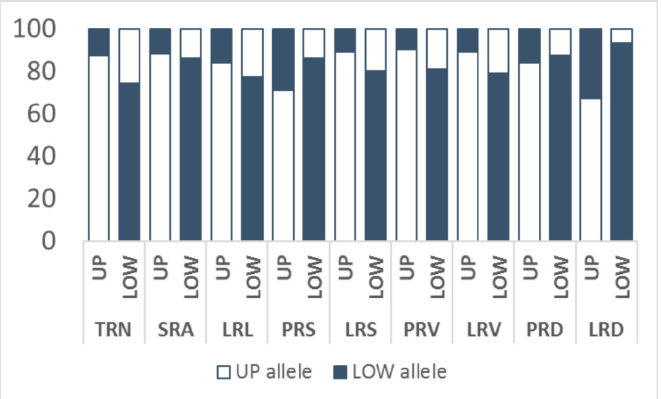
Figure 5. Marker allele frequency means from landraces within the upper and lower 10th percentile for the analyzed traits. All significant markers shown in Table 4 are included. TRN, total root number. SRA, seminal root angle. PRL, primary root length. LRL, total lateral root length. PRS, primary root surface. LRS, total lateral root surface. PRV, primary root volume. LRV, total lateral root volume. PRD, primary root diameter. LRD, mean lateral root